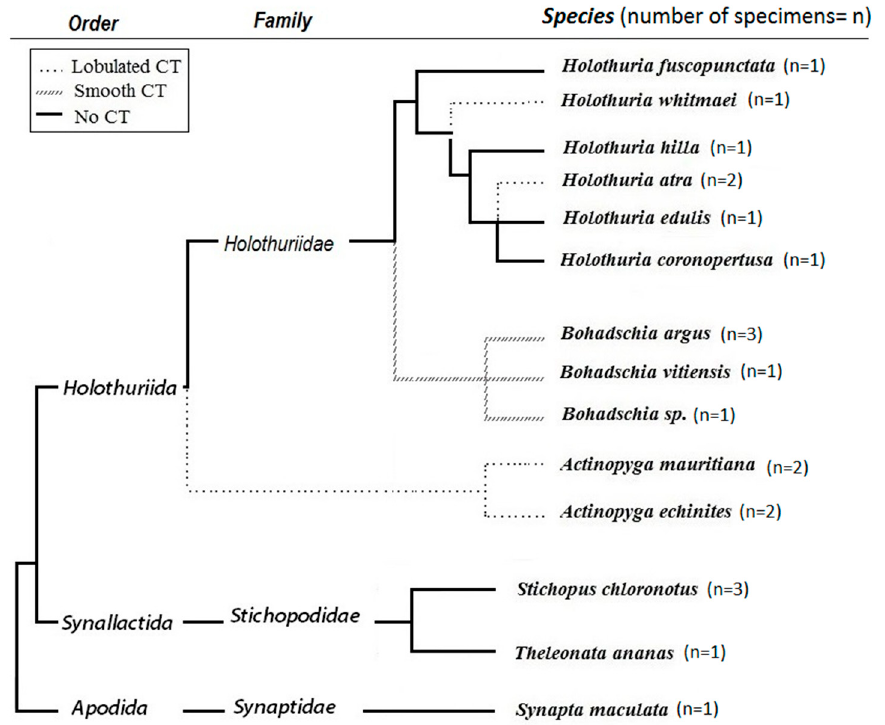
Figure 1. Phylogeny tree and presence / absence of Cuvierian Tubules (CTs) in studied sea cucumbers (n = number of tested specimens; adapted from [32,44–46]).